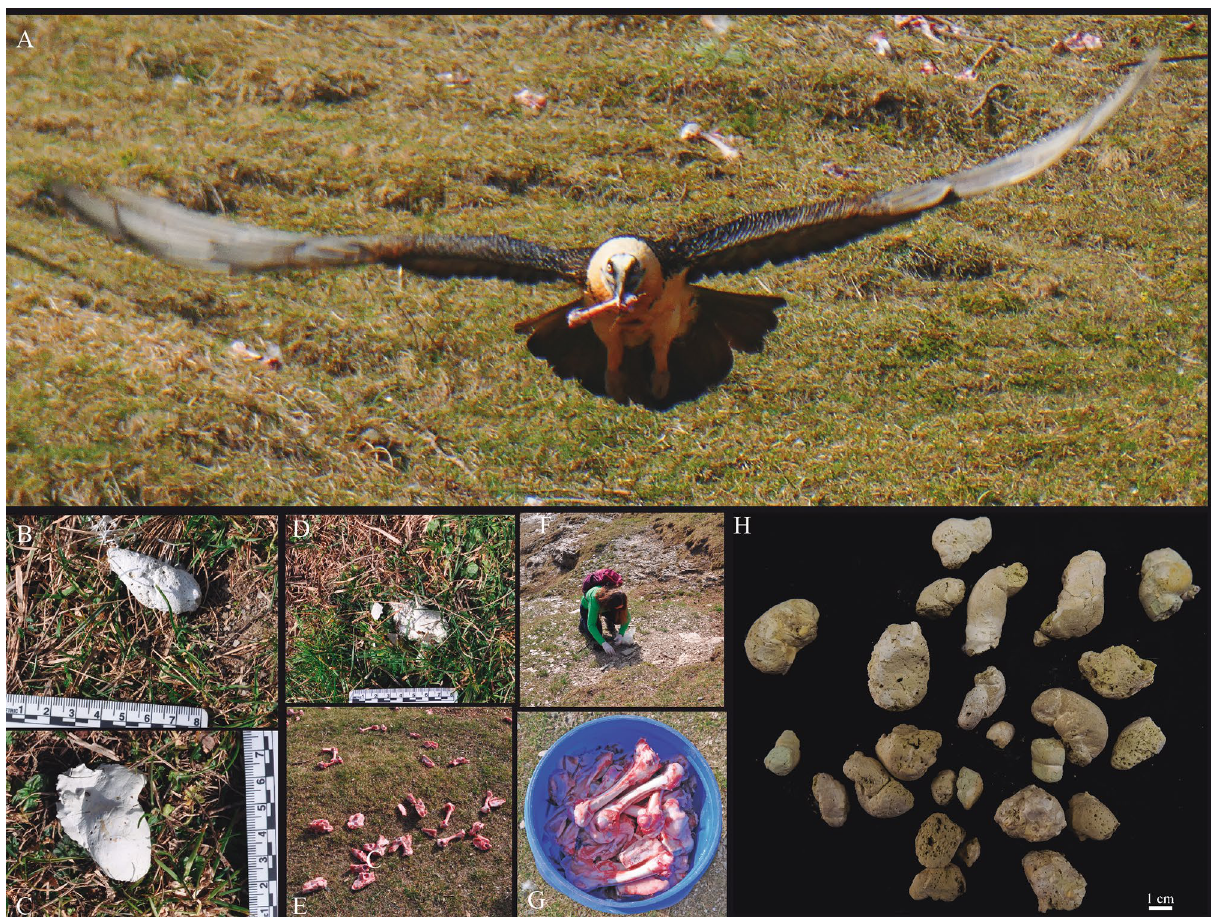
Figure 2. Supplementary feeding station located in the Ordesa and Monte Perdido National Park. ( A ) Adult bearded vulture with a sheep bone while flying. ( B , C ) and ( D ). Bearded vulture scats recovered for the present study. ( E ) and ( G ) Sheep bones used to feed vultures. ( F ) One of the authors collecting faecal samples. ( H ) Adult bearded vulture scats recovered from a modern-day nest (Huesca,